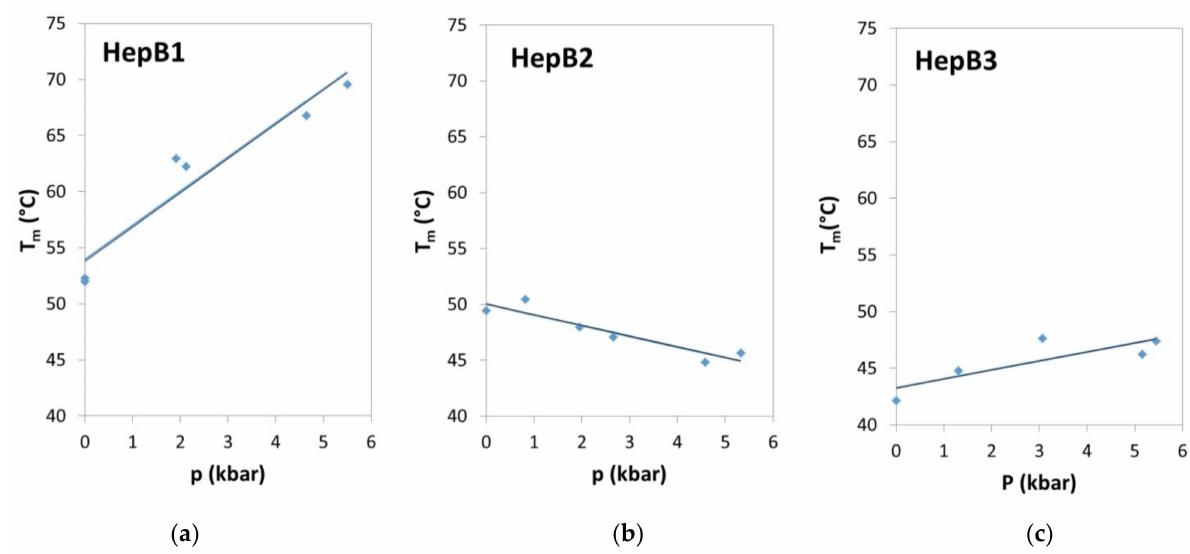
Figure 3. Pressure dependence of the unfolding temperature values for the three HepB variants. ( a ) HepB1, ( b ) HepB2, ( c ) HEpB3. The temperature values are pH-corrected as described in the